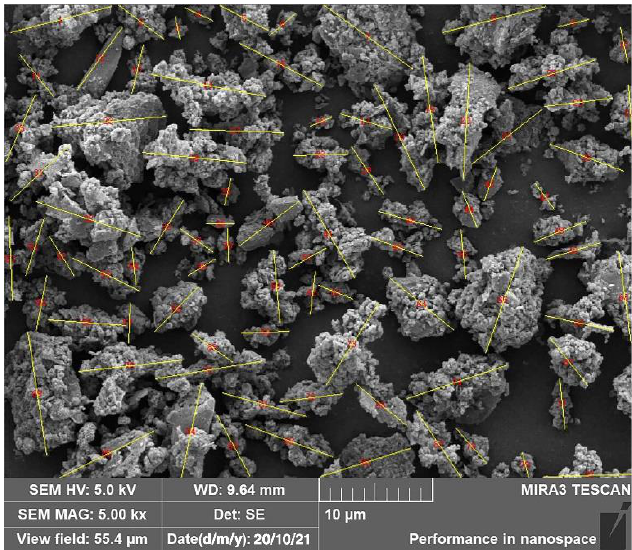
Figure 7. Fly ash particle morphology.